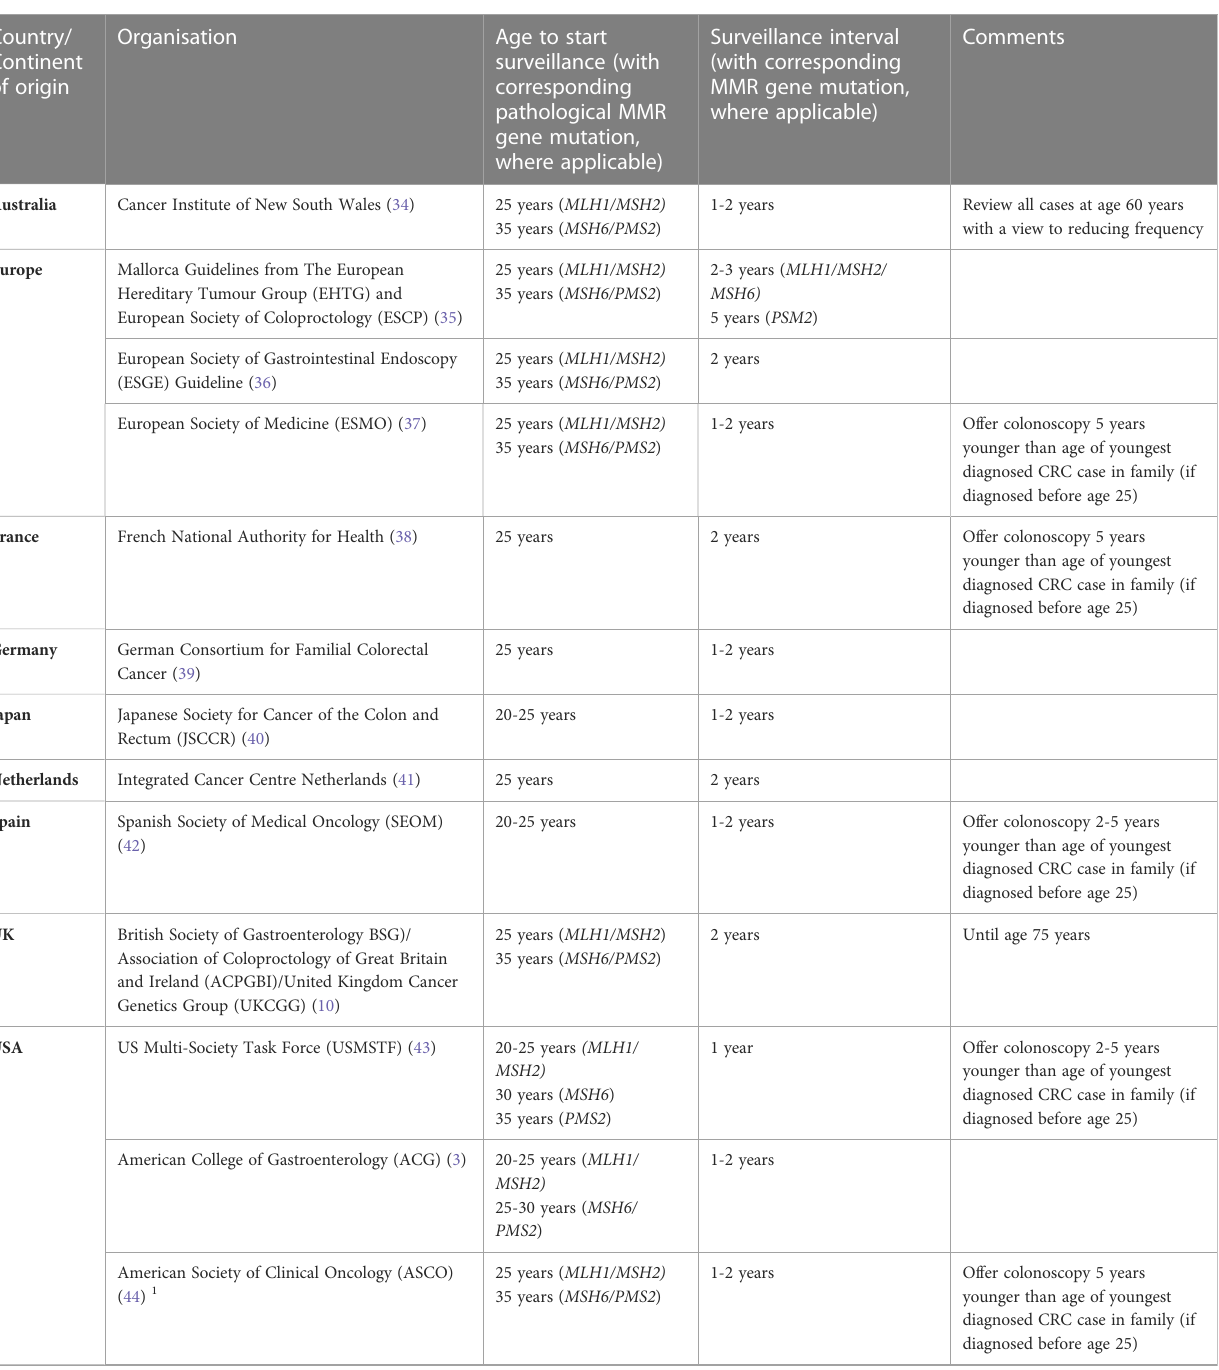
TABLE 2 Current recommendations for colorectal cancer surveillance from different national and international organisations. Country/ Organisation Age to start Continent